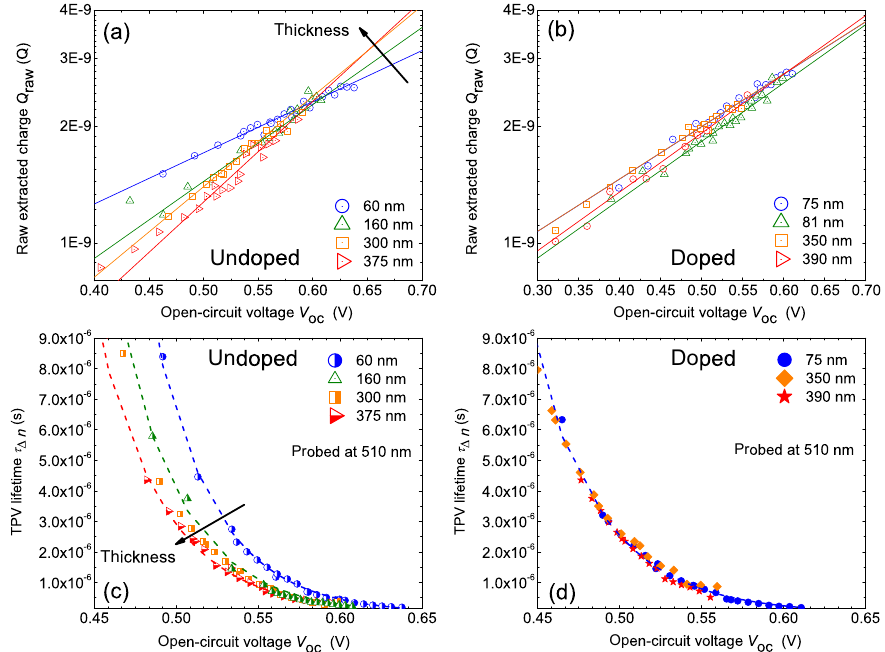
FIG. 6. Charge extraction at open circuit and TPV lifetimes for DPP-TT-T − PC 71 BM devices. Raw charges at open circuit extracted under short-circuit bias for different thicknesses for (a) low-level doping and (b) high-level doping. The way extracted excess carriers scale with light intensity is radically different depending on the doping level. TPV lifetime at different open-circuit voltages and thicknesses for (c) the low-level doping and (d) the high-level